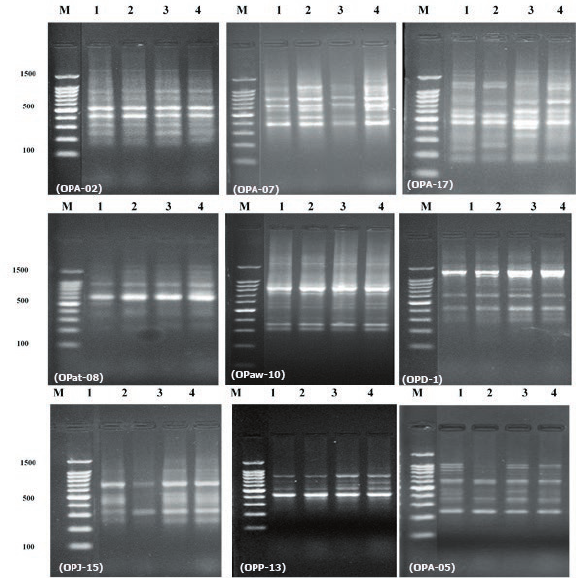
Figure 2. RAPD profile generated by 9 primers using roots of dif- ferent Vicia faba Misr 3 cultivar subjected for different periods in 5 mM AlCl 3 . Lanes1, 2, 3 and 4: 0.0, 6, 12 and 24 hr, respectively. M: DNA